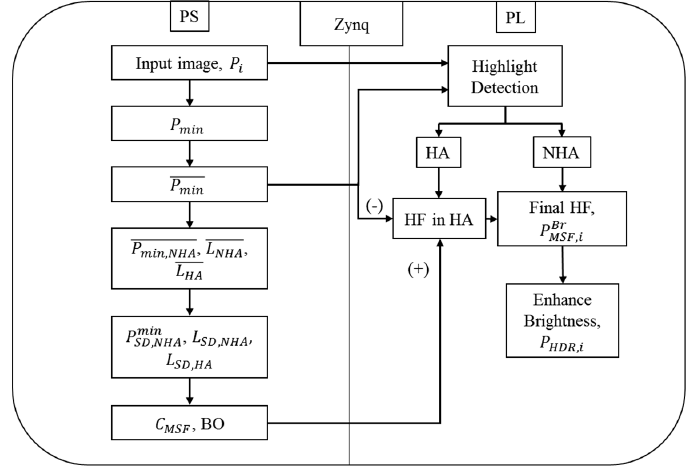
Figure 6. Our implementation steps/operations in PS and PL side.